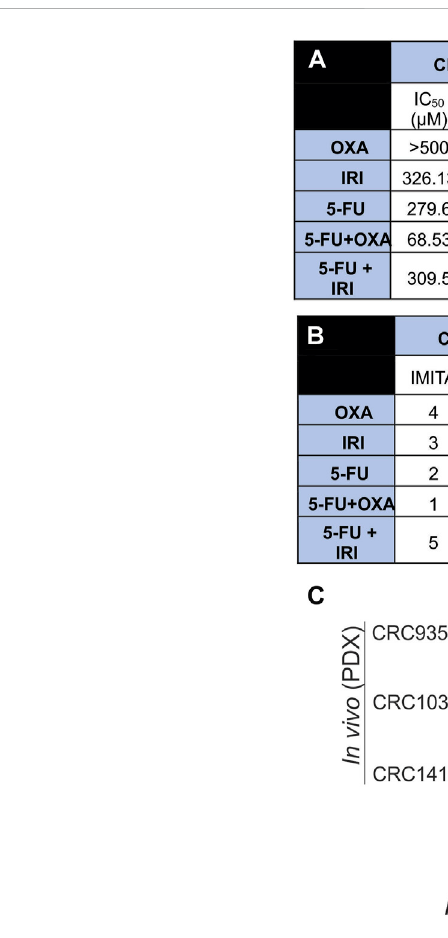
FIGURE 5 Invitro-invivo drugresponsecorrelation. (A) TGIvaluesfrom invivo PDXmodelsandIC 50 valuesofdoseresponsecurvesobtainedfrom